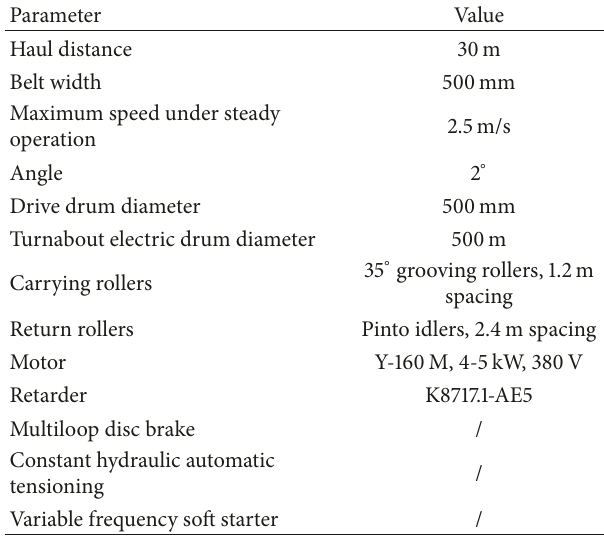
Table 3: Experimental belt conveyor system